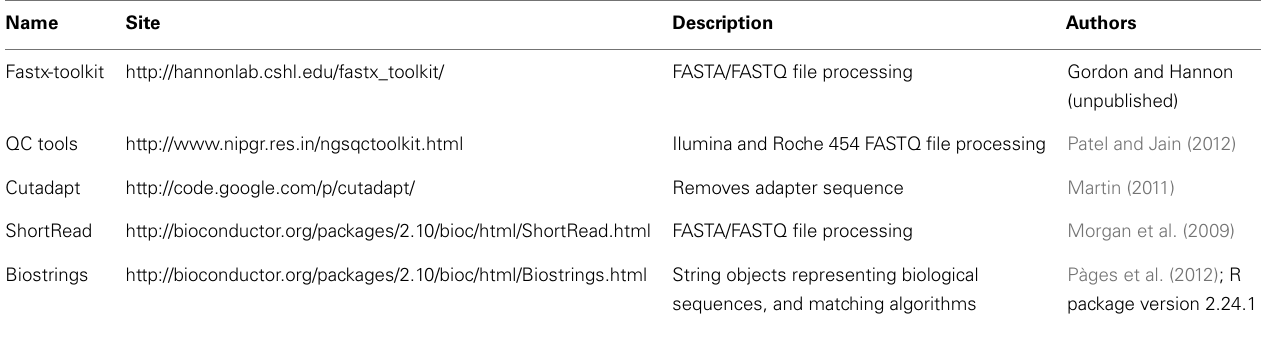
Table 1 | Preprocessing alignment